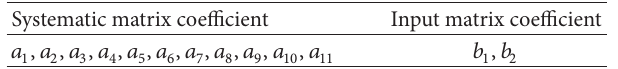
Table 2: Nomenclature for